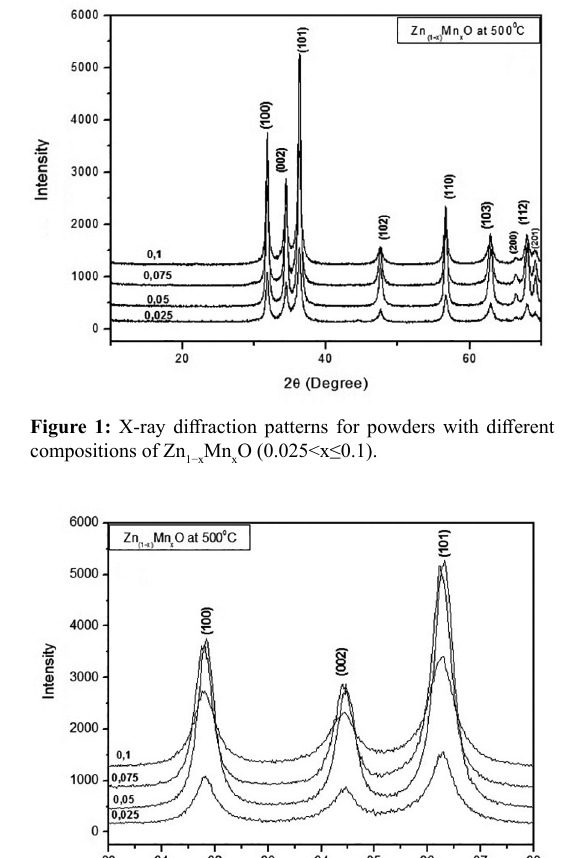
Mn O (0.025 < x ≤ 0.1) in the 1−x x